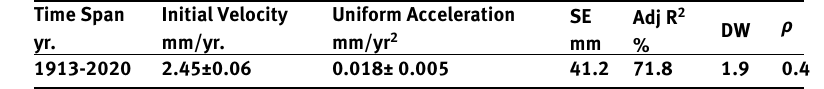
Table 2. OLS solution statistics. Trend and uniform acceleration estimates are statistically significant at α = 0.05.